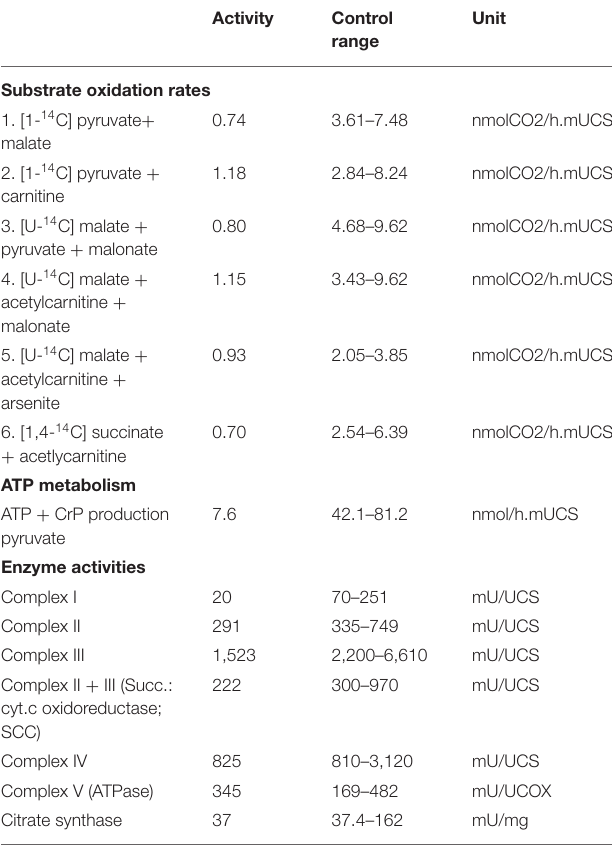
TABLE 2 | Results of the mitochondrial enzyme diagnostics. Activity Control